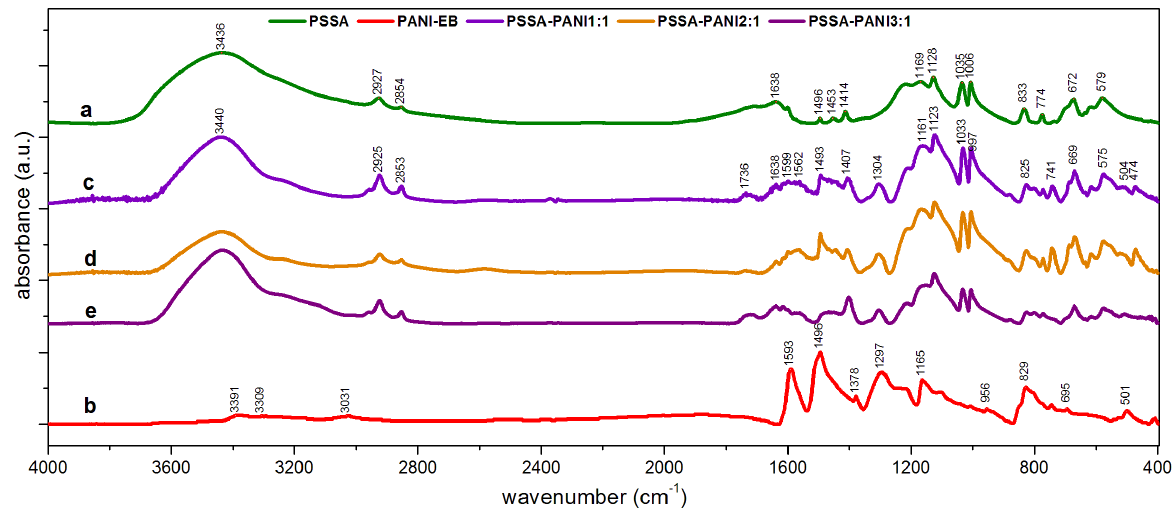
Figure 2: Recorded FT-IR spectra of (a) PSSA, (b) PANI-EB, (c) PSSA-PANI 1:1, (d) PSSA-PANI 2:1, (d) PSSA-PANI 3:1